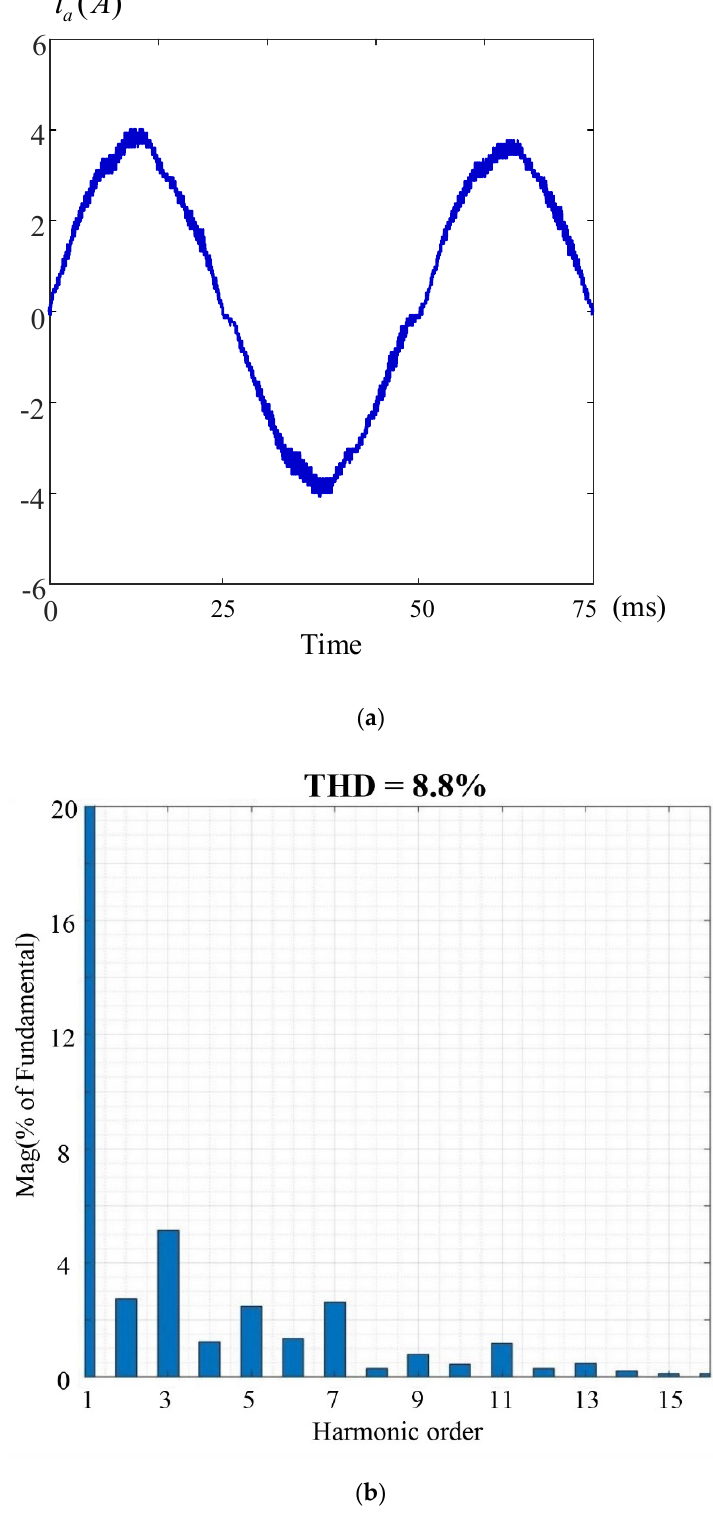
Figure 15. Measured a -phase current using predictive controller. ( a ) waveform, ( b ) harmonics.